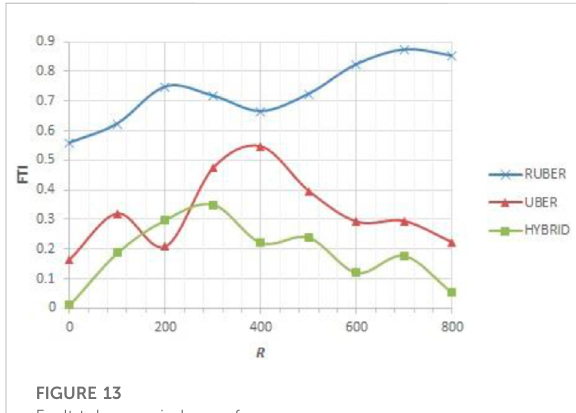
FIGURE 13 Fault tolerance index performance.